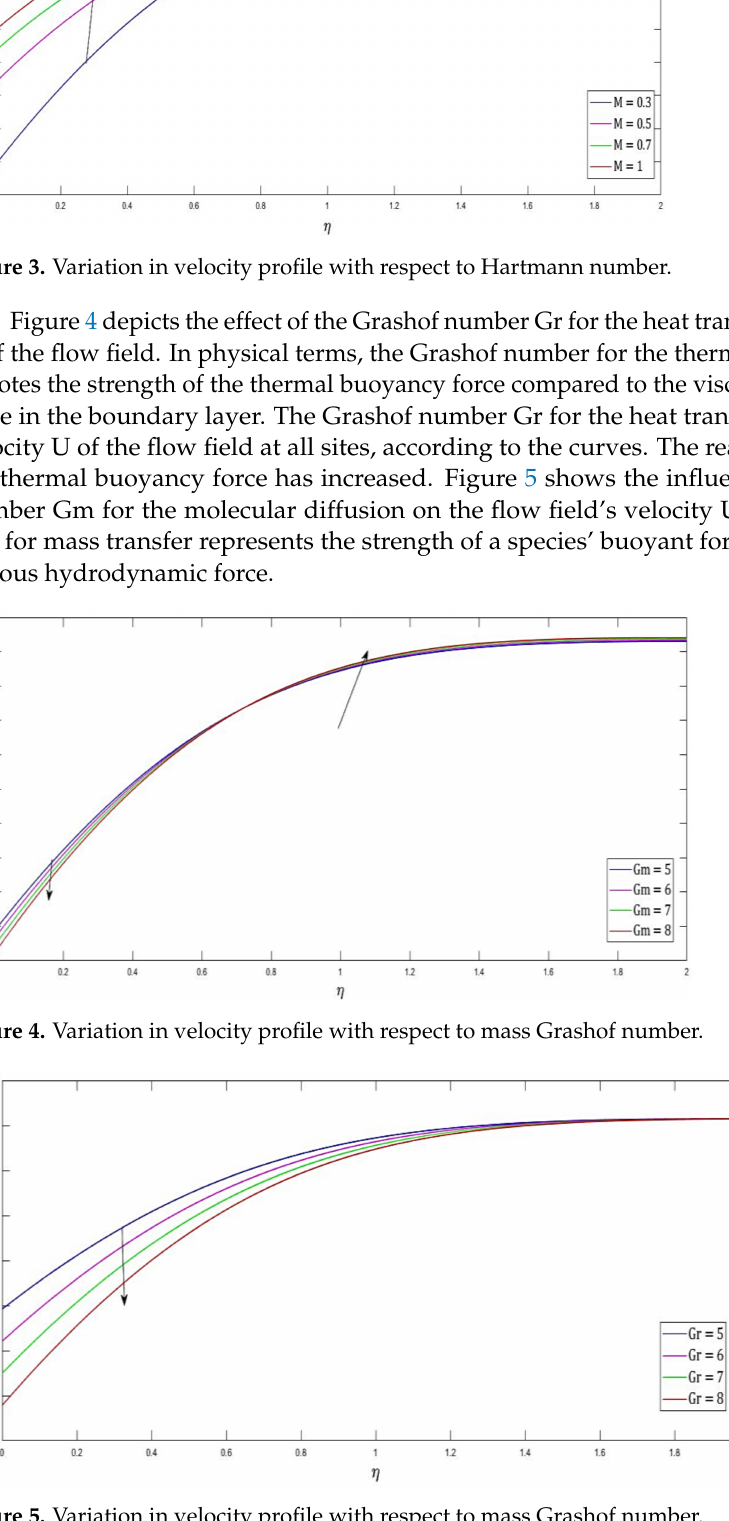
Figure 5. Variation in velocity profile with respect to mass Grashof